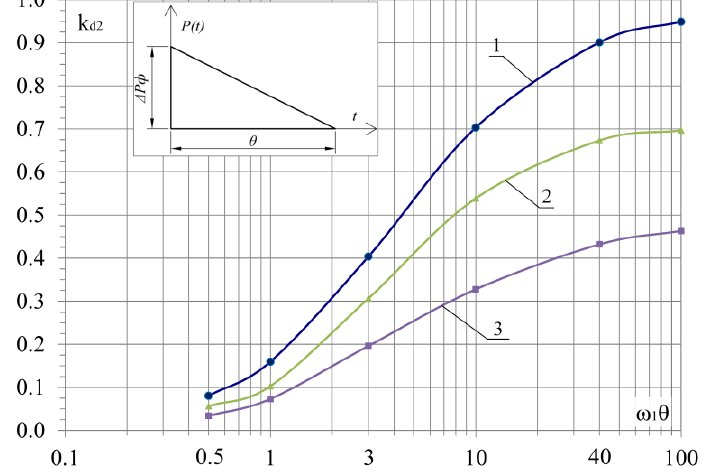
Fig. 6. Dynamic factor diagram for beams in conventional elastic stage (limit state 1a) on yielding supports subjected to various compression depending on ω 1 θ parameter, 1 – no compression, 2 – compression N=0,2N max , 3 – compression N=0,4N max